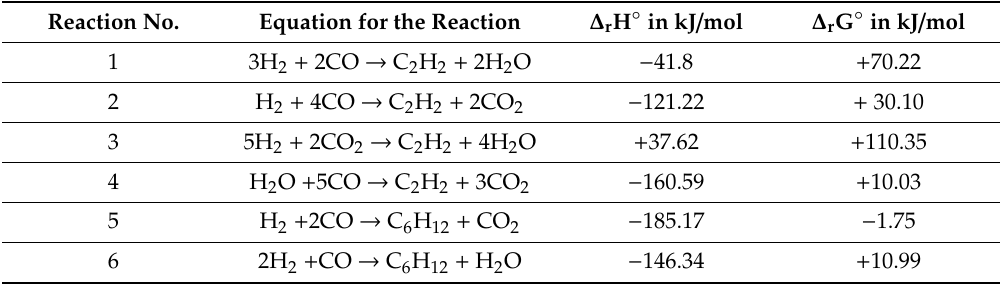
Table 1. Thermodynamic enthalpies for the synthesis of acetylene at 227 ◦ C, considering the hydrogenation of CO with various ratios of H 2 / CO, the hydrogenation of CO 2 and the hydrolysis of CO. The synthesis of 1-hexene at 427 ◦ C is considered through the hydrogenation of CO. Values are adapted from chapter 2 in Anderson [30] and are reported here in kJ / mol of acetylene and 1-hexene. Reaction No. Equation for the Reaction ∆ r H ◦ in kJ / mol ∆ r G ◦ in kJ / mol 1 3H 2 + 2CO → C 2 H 2 + 2H 2